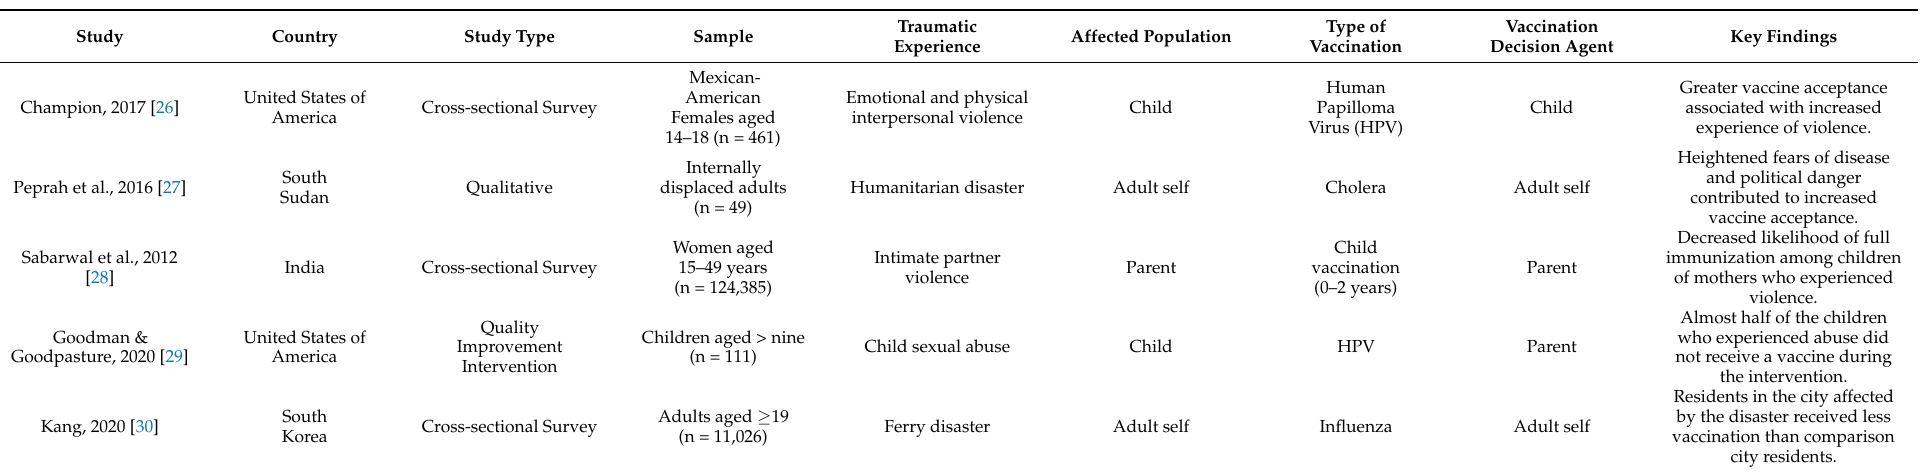
Table 1. Studies relating to traumatic experiences and